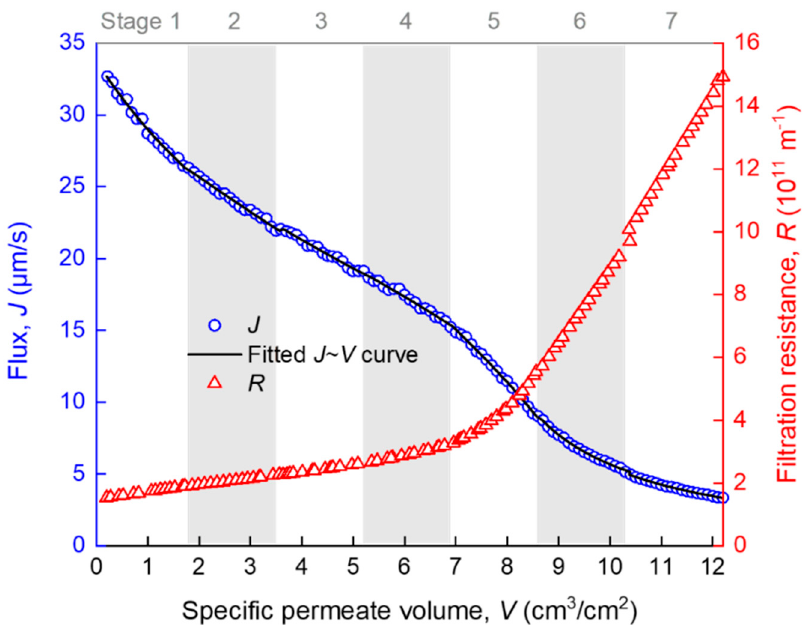
Figure 3. Variation of membrane flux and filtration resistance during the filtration process. Data are given as average from two repeated experiments with a relative error smaller than 4.4% (the error bars are thus omitted for simplicity of presentation). The R-squared values for the fitting in stages 1–7 were 0.983, 0.990, 0.985, 0.983, 0.996, 0.980, and 0.987, respectively.